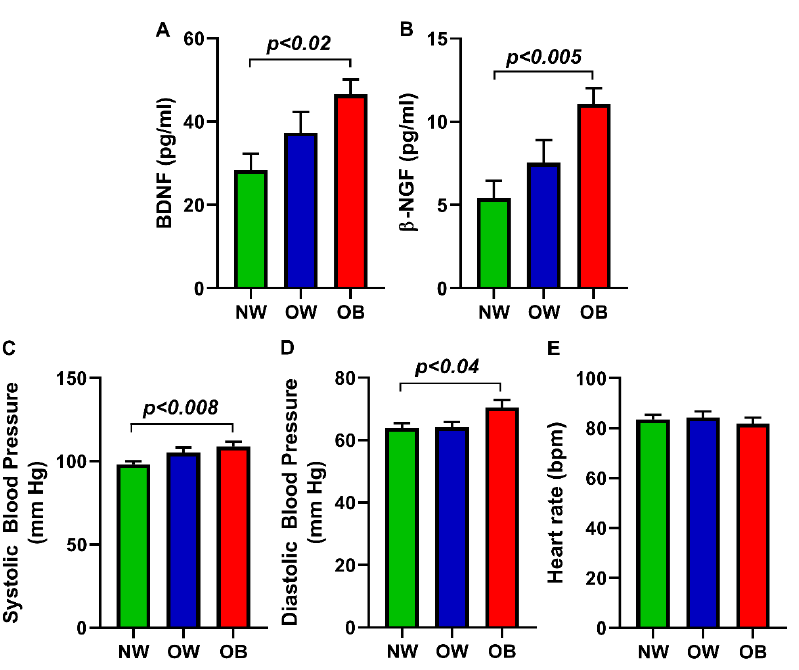
Figure 1. Bar graph shows the neurotrophin and pressure levels in the NW, OW, and OB groups. ( A ) BDNF, ( B ) NGF, ( C ) systolic pressure, ( D ) diastolic blood pressure, and ( E ) heart rate.